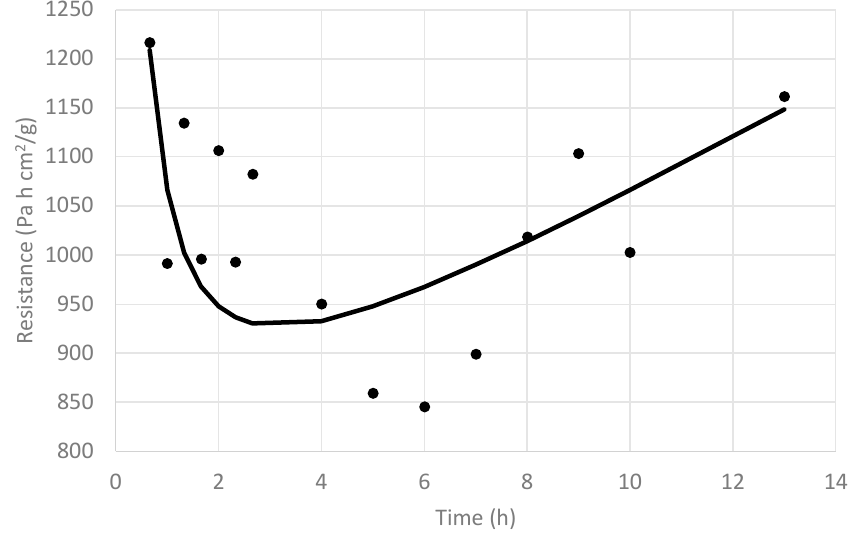
Figure 8. Values of (R T ) along the freeze-drying time ( • ) and its corresponding tendency line ( — ) of whole nontreated blueberries.